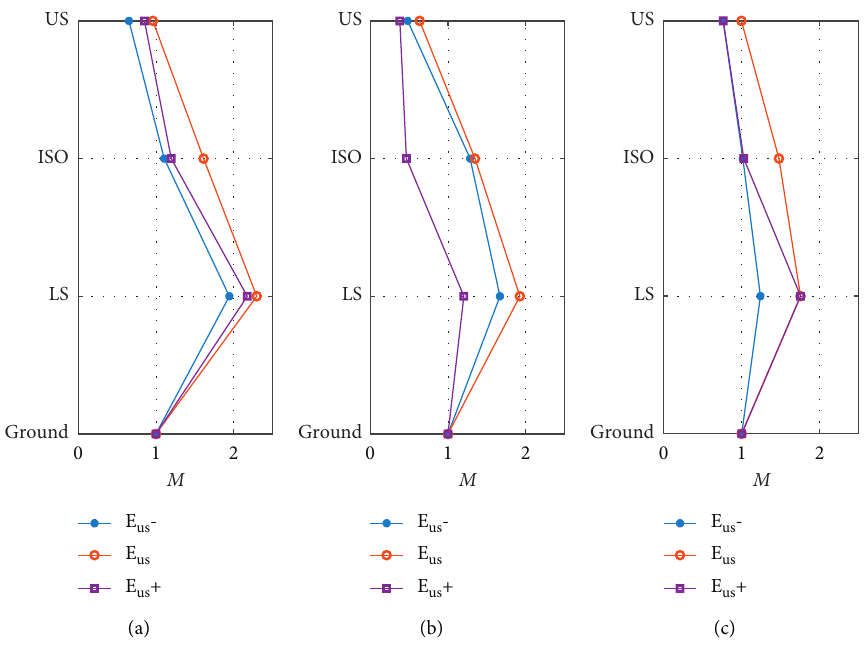
Figure 16: The magnification factor M for Case 3: (a) El Centro-EW, (b) Taft-NS, and (c)